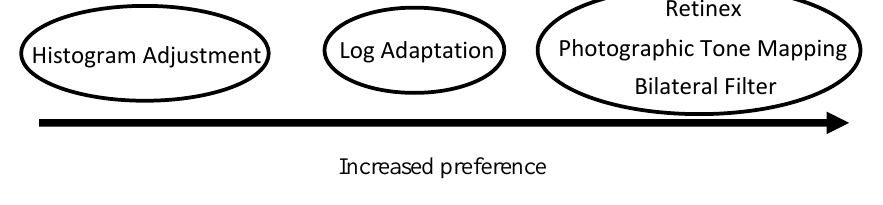
Figure 9. Diagram summarizing the paired comparison results of the first psychophysical experiment. Algorithms are listed from left to right in order of increased preference; in terms of how much visual information or detail seemed to be visible by test